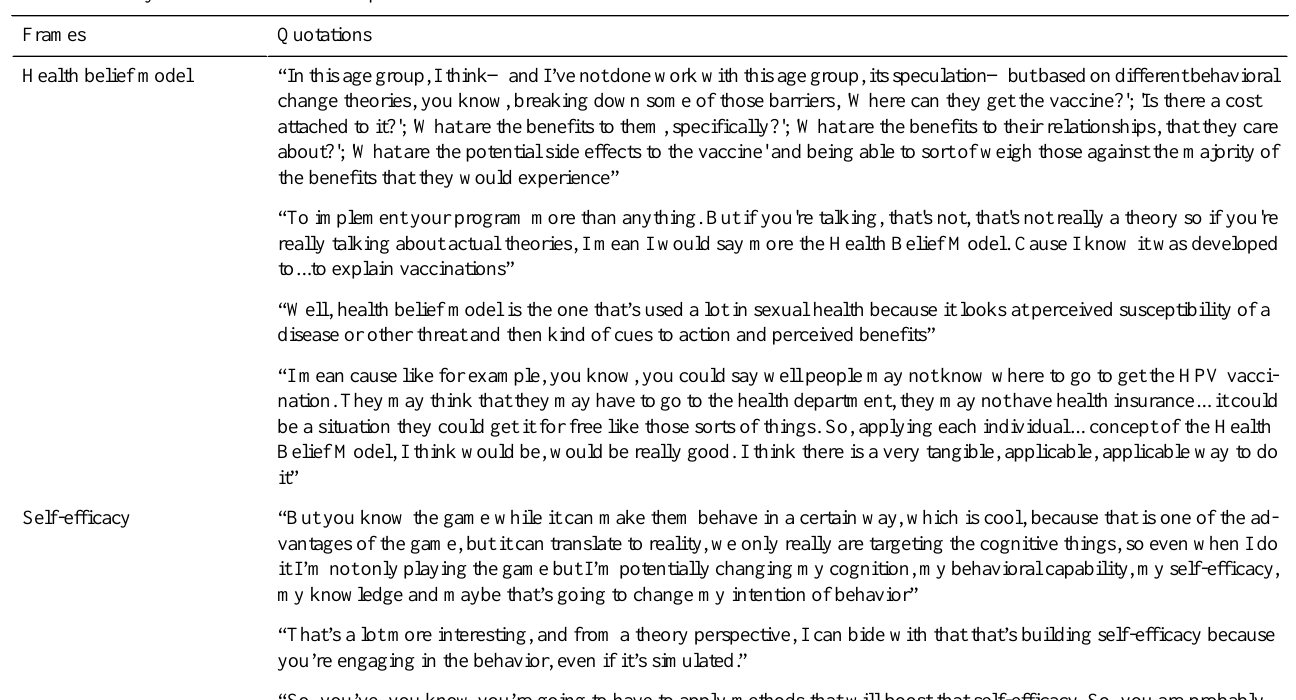
Table 1. Theory or theoretical construct